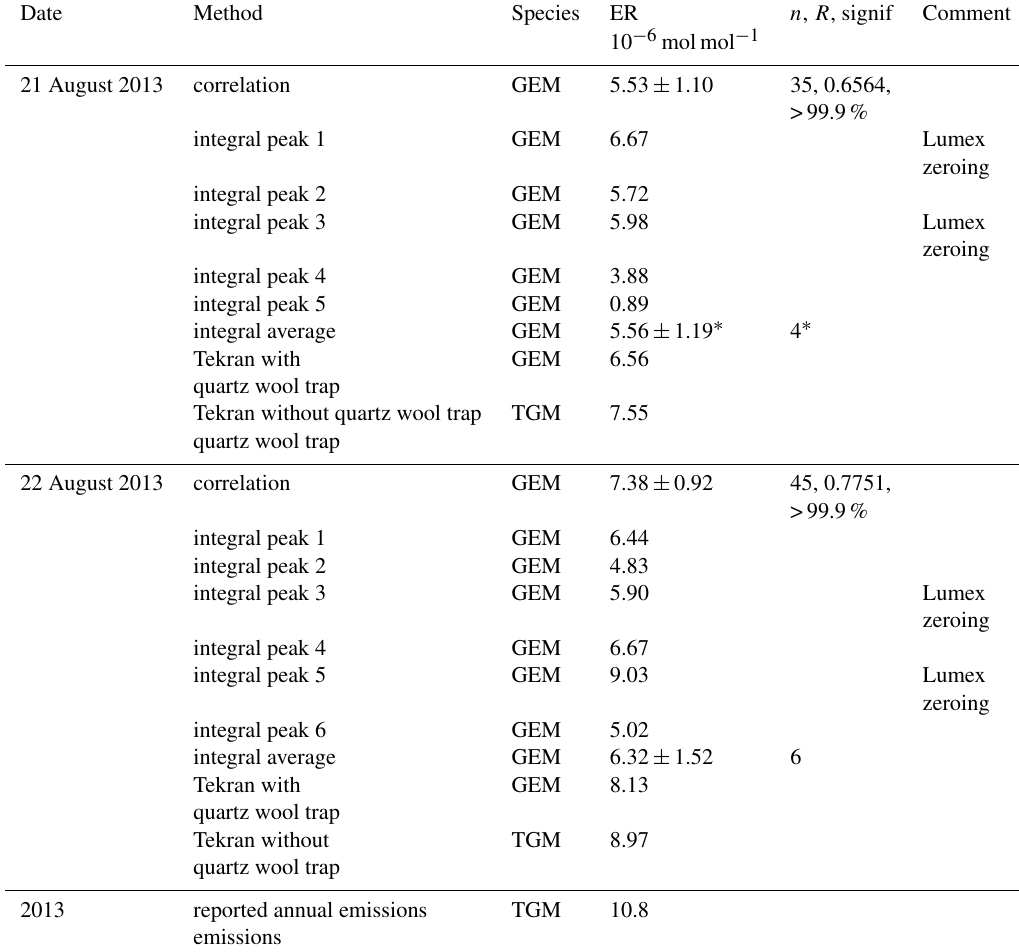
Table 2. Hg / SO 2 enhancement ratios (ERs). Correlation method: 10s average Hg concentrations measured by Lumex correlated with 10s average SO 2 mixing ratios. Only Hg values with SO 2 concentrations >10ppb were taken with uncertainties set to 1ngm − 3 for Lumex and 0.5ppb for SO 2 . Integral method: 1s Lumex and SO 2 signals integrated over the duration of Lumex measurement, measurements of Tekran with quartz wool taken as Lumex background concentrations (i.e., 1.27 and 1.25ngm − 3 for 21 and 22 August, respectively). SO 2 background mixing ratio was 0.83 and 0.66ppb on 21 and 22 August, respectively. Since Tekran with a temporal resolution of 150s cannot resolve individual plume crossing, the integral of the Tekran signal encompasses the plumes 1–4 on 21 August and the plumes 1–6 on 22